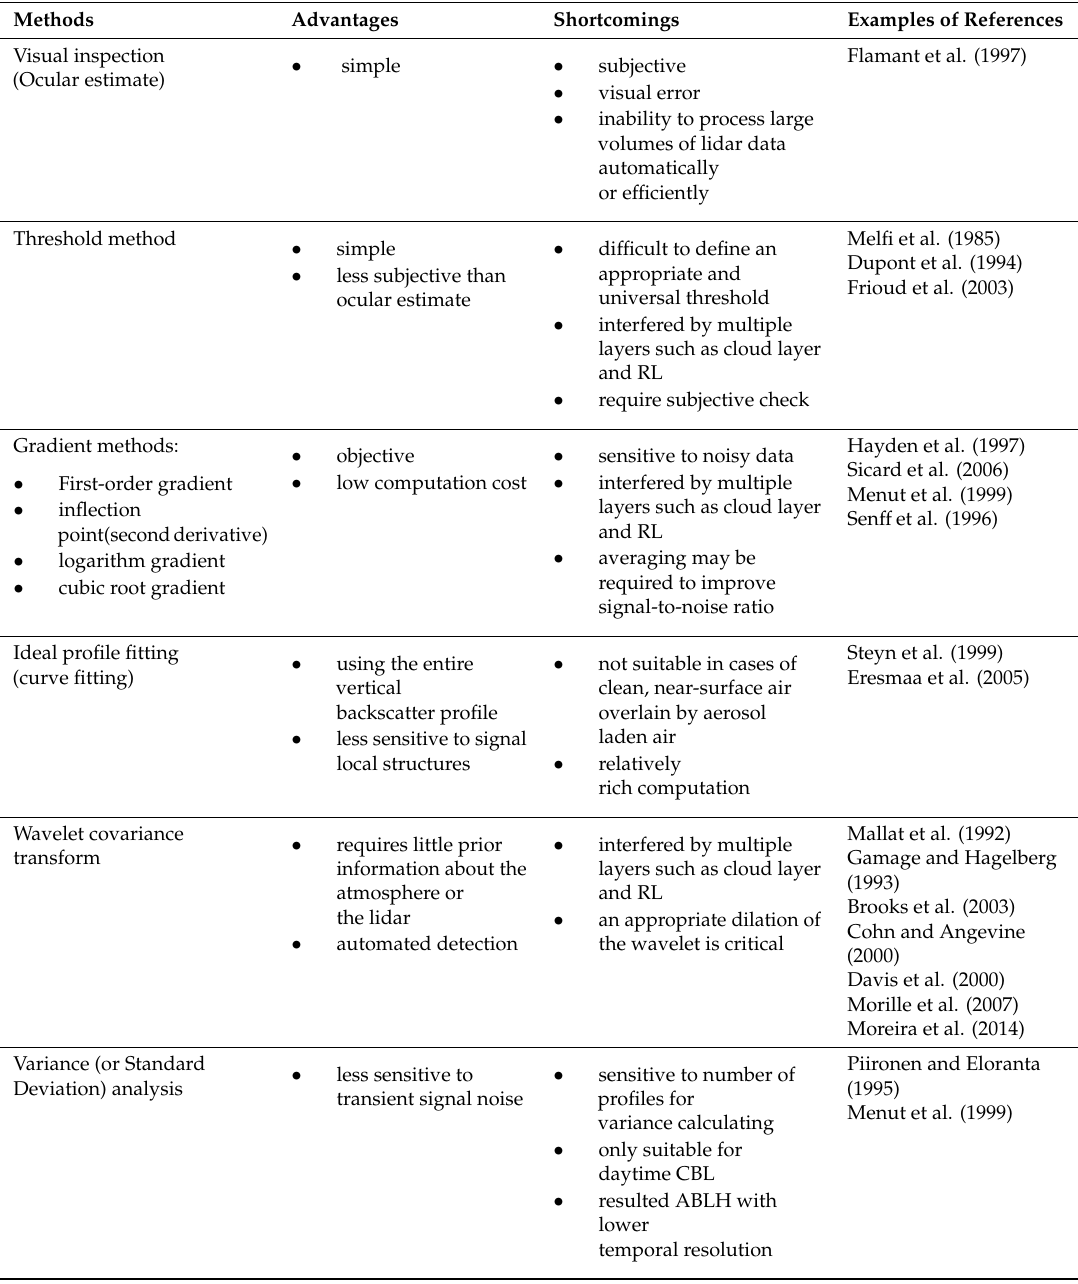
Table 2. Classical lidar-based methodologies to derive ABLH (RL, residual